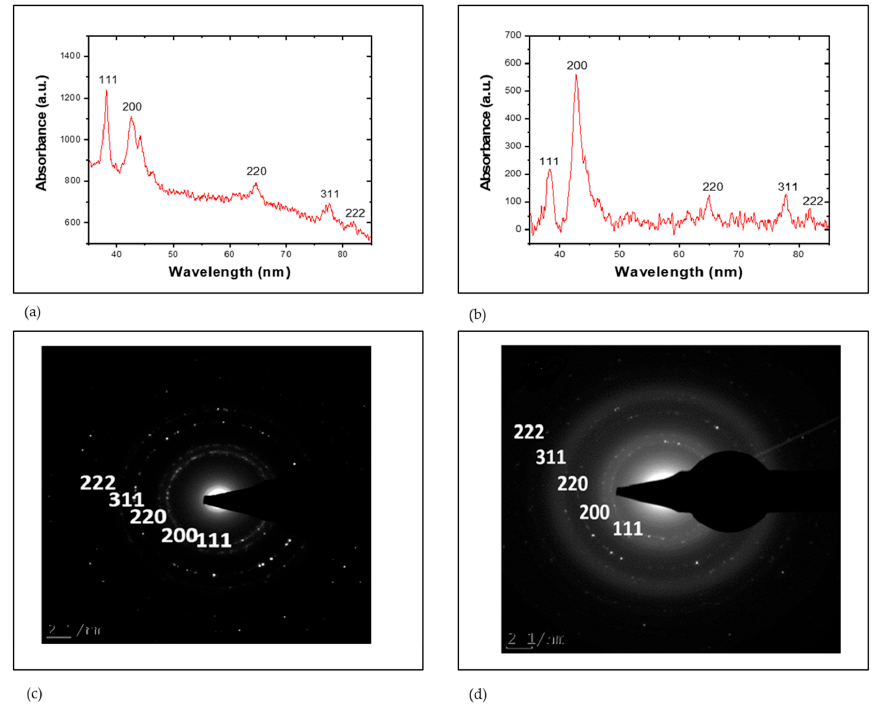
Figure 3. XRD and (SAED) patterns of the biogenic AuNPs as determined by XRD Spectroscopy and HR-TEM. XRD patterns of HB-AuNPs ( a ) and MGF-AuNPs ( b ); SAED patterns of HB-AuNPs ( c ) and MGF-AuNPs ( d ).